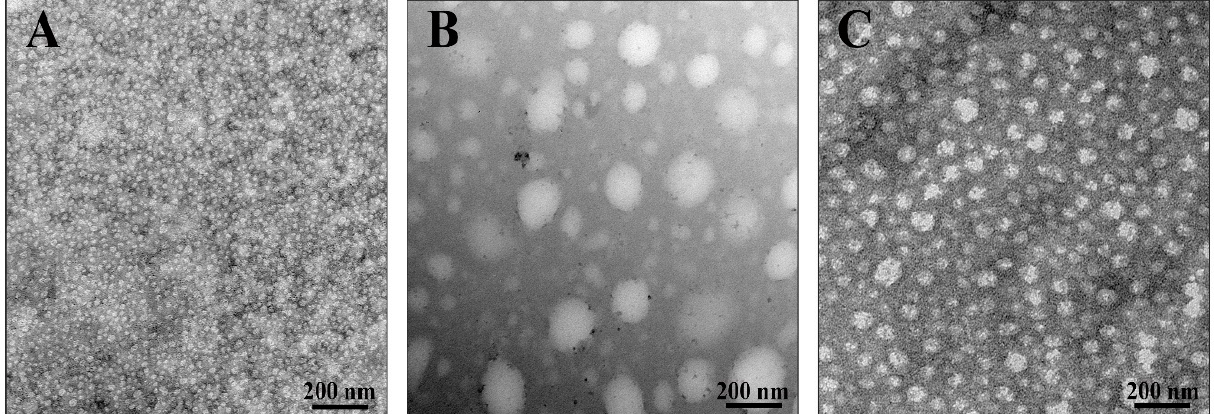
Figure 7. Images of purified S. aureus membrane vesicles visualized by transmission electron mi- croscopy. ( A ) MVs released by bacteria cultivated without tannins, ( B ) cultivated with PGG 40 µ M, ( C ) cultivated with dGVG 40 µ M. S. aureus MVs were purified by ultrafiltration and ultracentrifuga- tion. Images are representative of at least three independent experiments, and representative images are shown. Scale Bar: 200 nm.